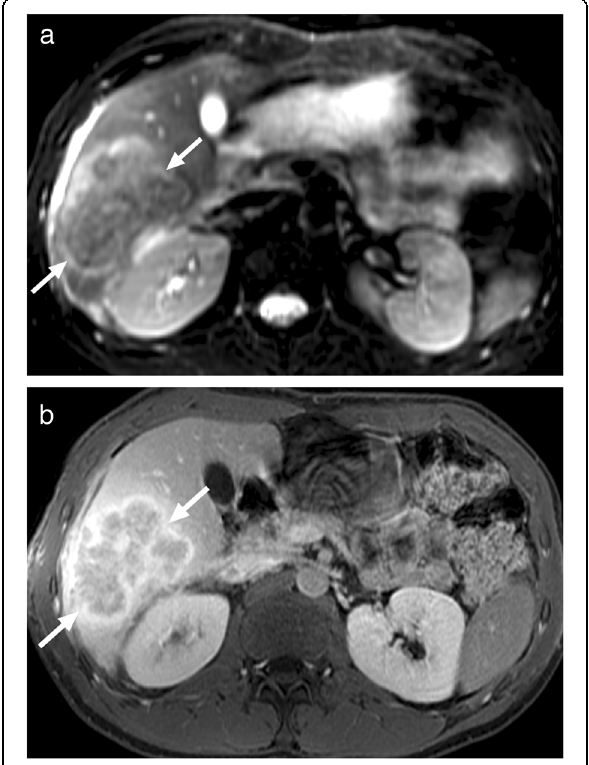
cholangiocellular carcinoma, of this mass revealed